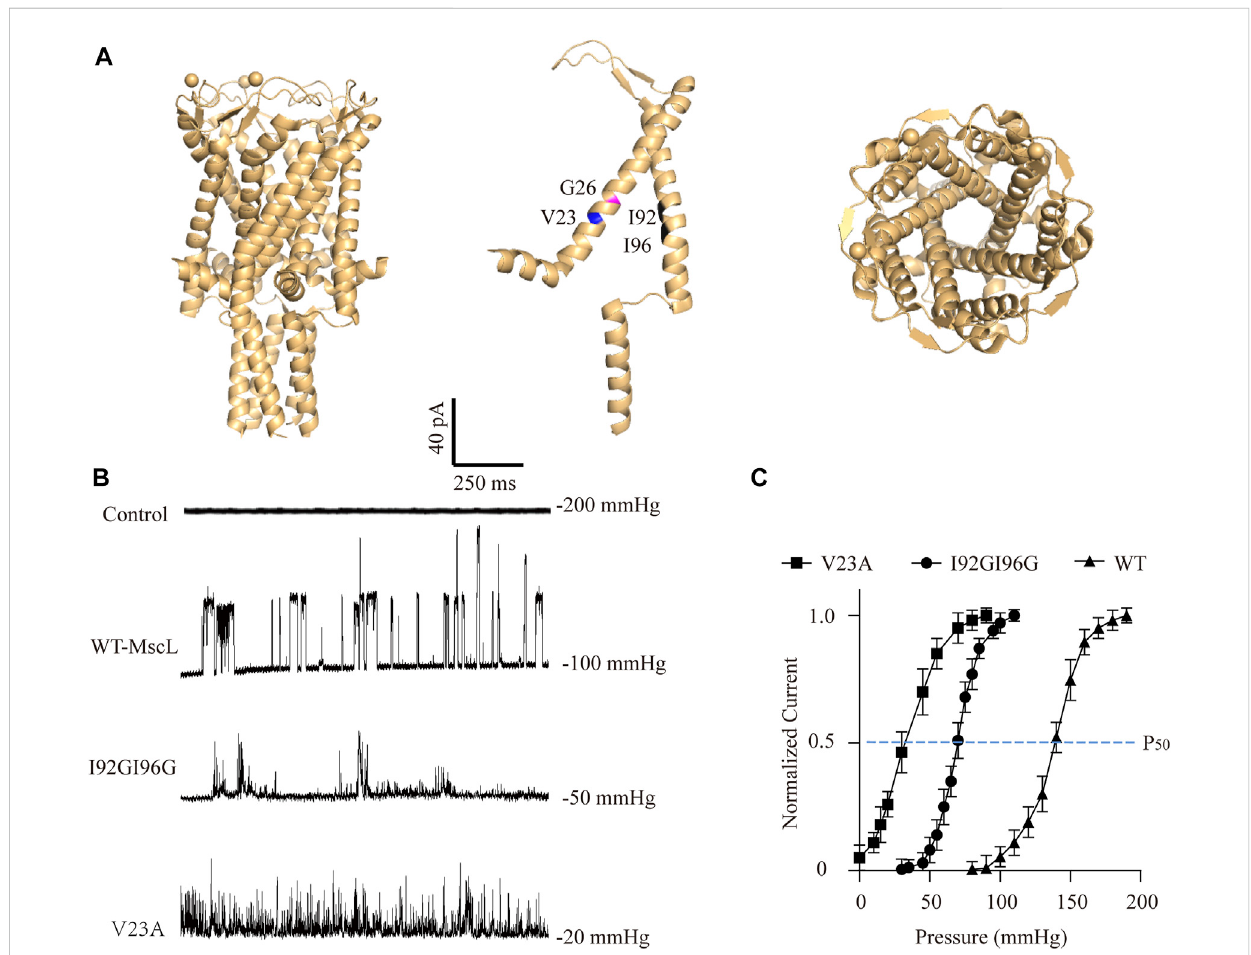
Electrophysiological analysis of the MscL channels expressed in A549 cells. (A) Illustration of the crystal structure of MscL channel (PDB 20AR). Amino acid sites-Val23 (blue), Gly26 (magenta), Ile92 and Ile96 (black) are highlighted. (B) Traces show single channel activity at the indicated holding pressure in Vhold = +40 mV. (C) Normalizedcurrent-pressure relationshipof WT, I92GI96G and V23A MscL channels recordedfrom inside-out